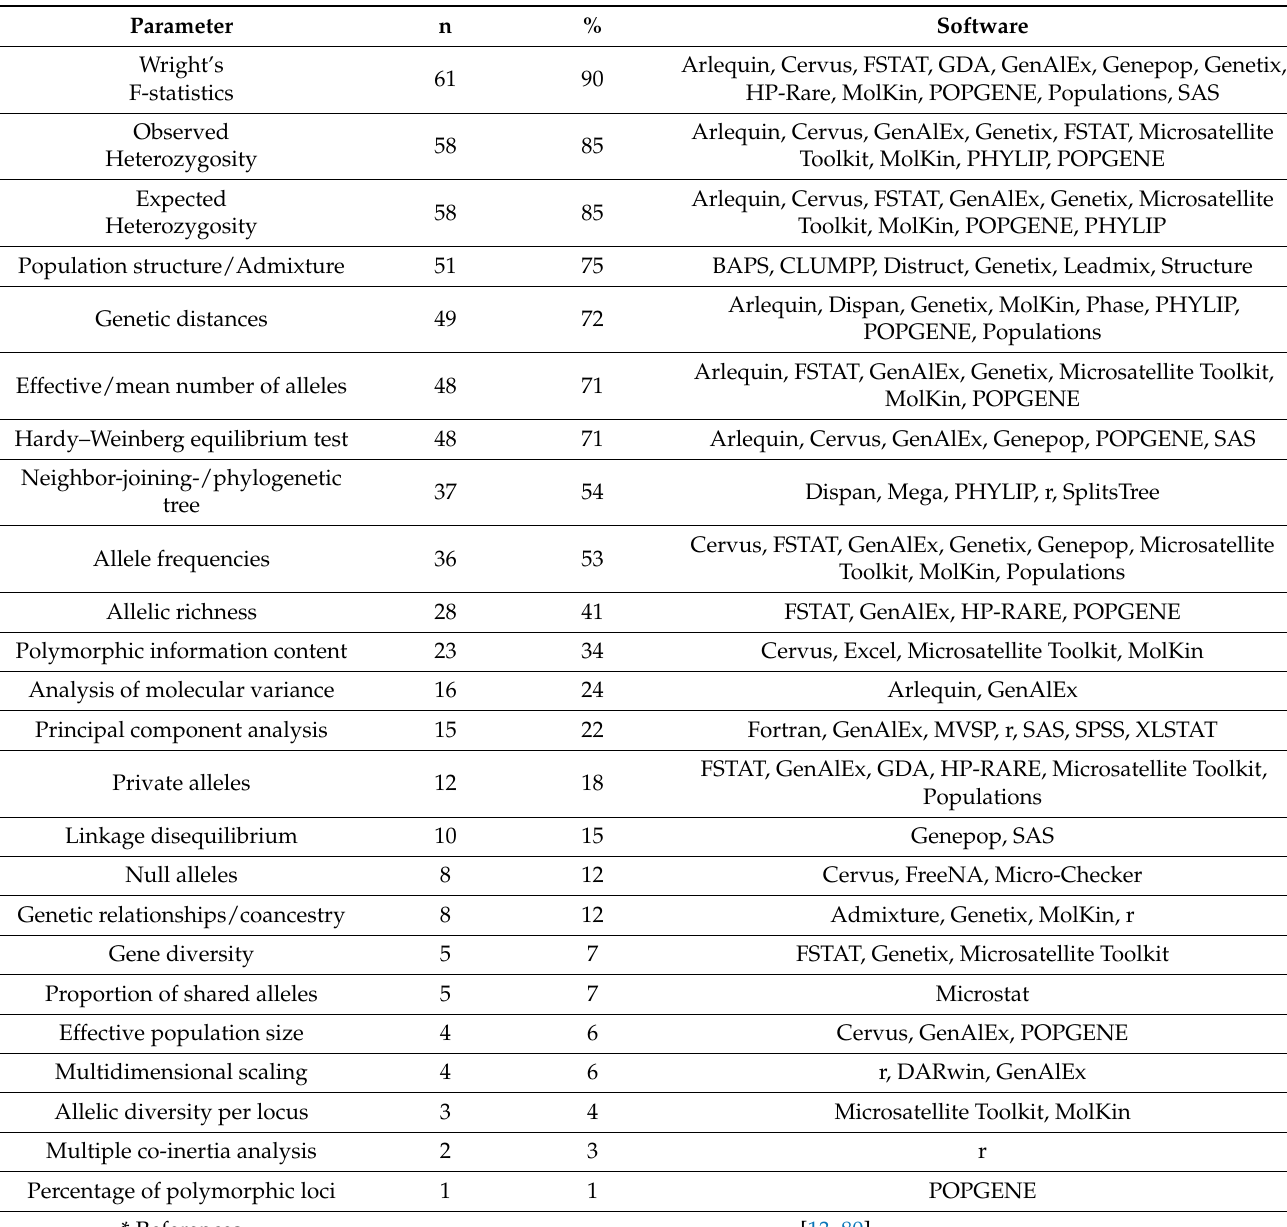
Table 1. Percentage of computed diversity parameters in 68 studies * involving microsatellite analysis, and the respective software programs used (for citations, see Table